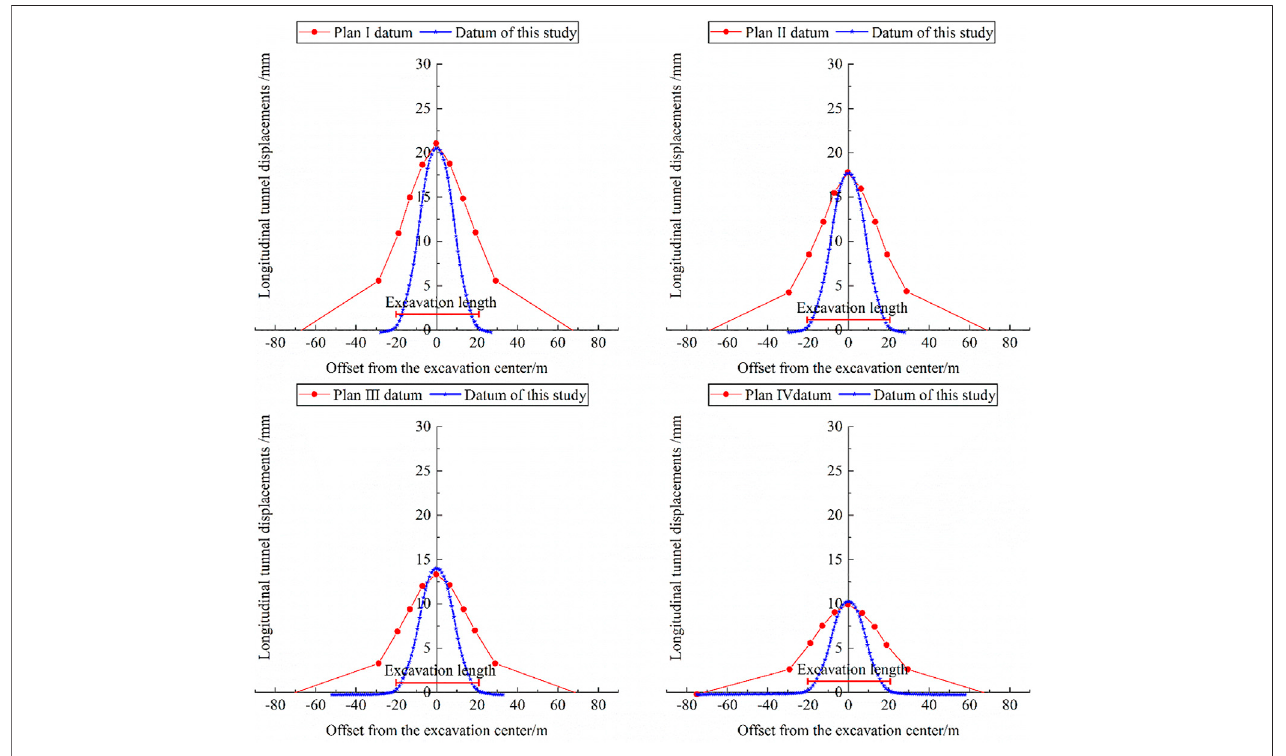
FIGURE 9 | Results comparison between this method and studies in Case Ⅱ